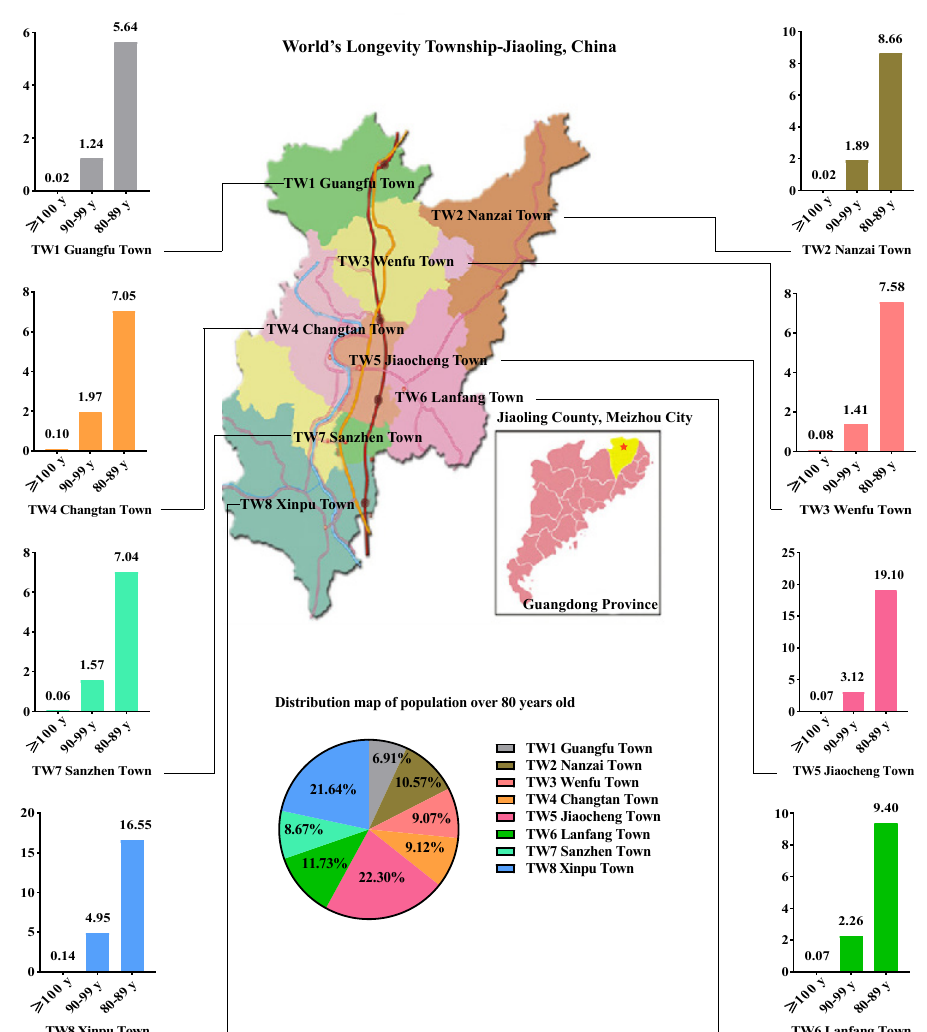
Figure 1. Distribution map of the population over 80 years old in one of world’s longevity townships; Jiaoling, Fig. 1 Distribution map of the population over 80 years old in world’s longevity township-Jiaoling, China.